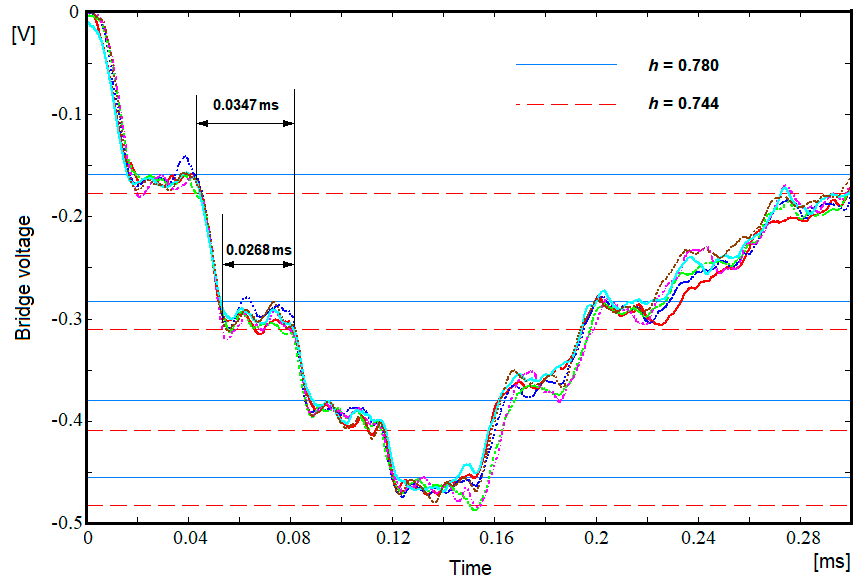
Figure 5. Signals recorded with the Wheatstone bridge from the transmitter bar for the tests on the long